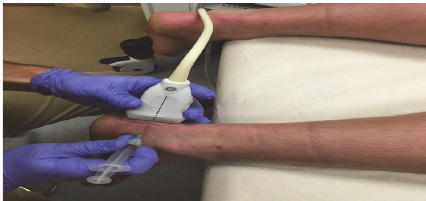
Figure 1: Photograph of sonographically guided prolotherapy injection procedure on 42-year-old male with chronic insertional Achilles calcific tendinosis shows simultaneous use of ultrasound probeand25-gaugeneedletotargetsignificantsonographicfeatures.